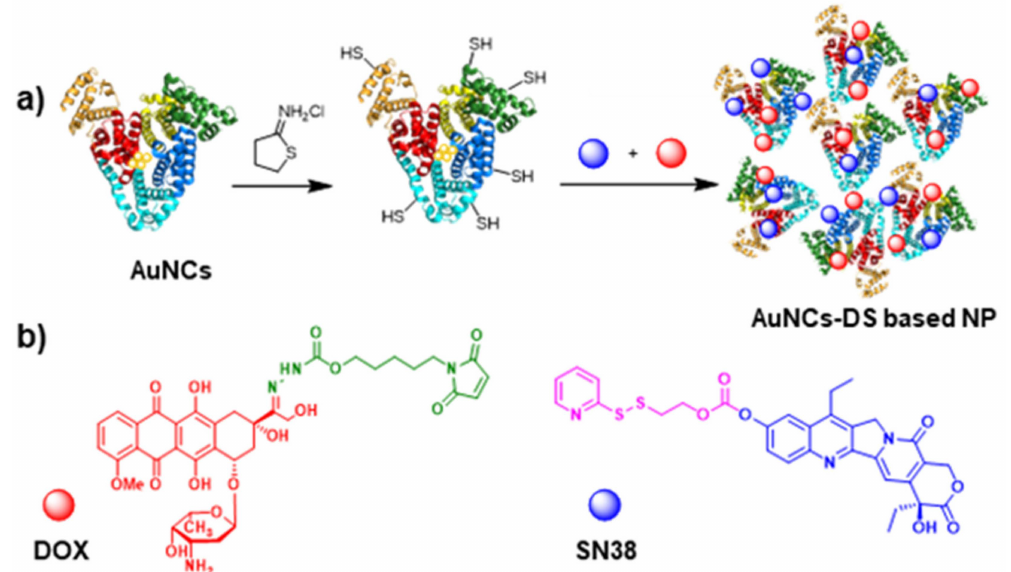
Figure 1. Synthesis of nanoparticles based on AuNCs modified with Doxorubicin (DOX) and SN38. ( a ) Schematic representation of the synthesis of DOX / SN38-AuNCs-based nanoparticles for combined chemotherapy; ( b ) Representation of DOX (red) modified with a pH-sensitive linker (green) and SN38 (blue) modified with a redox-sensitive linker (pink).